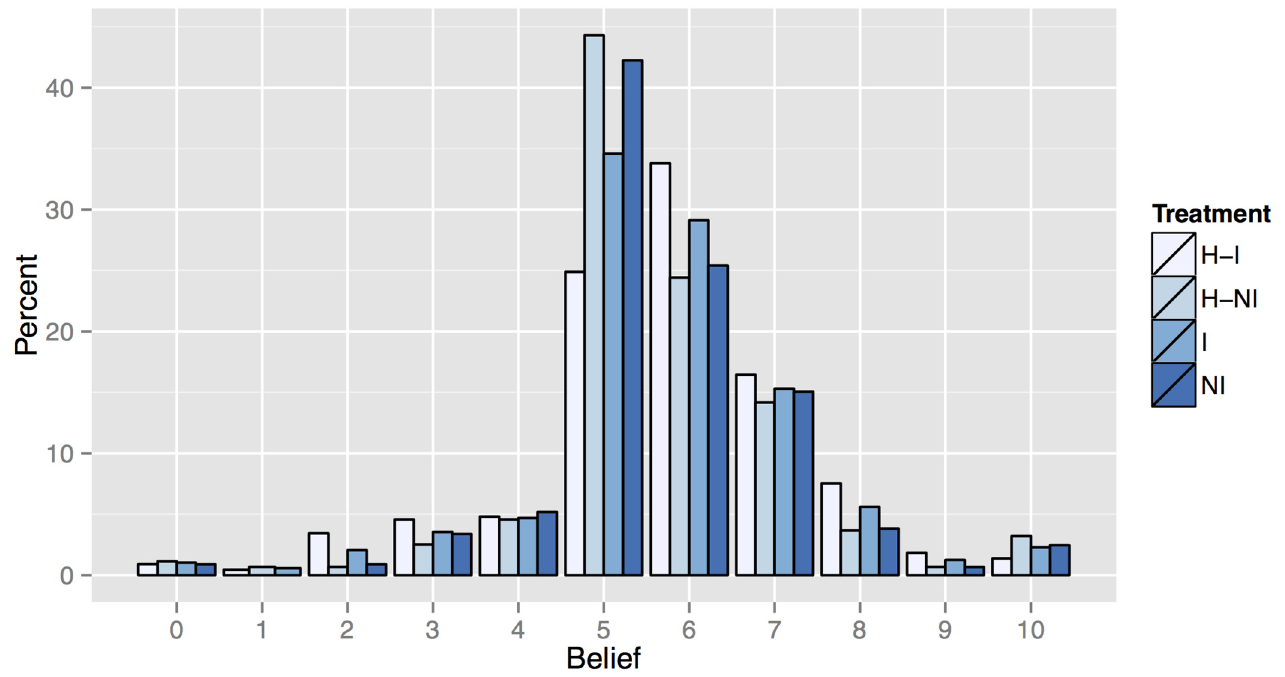
Fig 4. Beliefs of Individual Allocations to the Group Account, by Treatment.